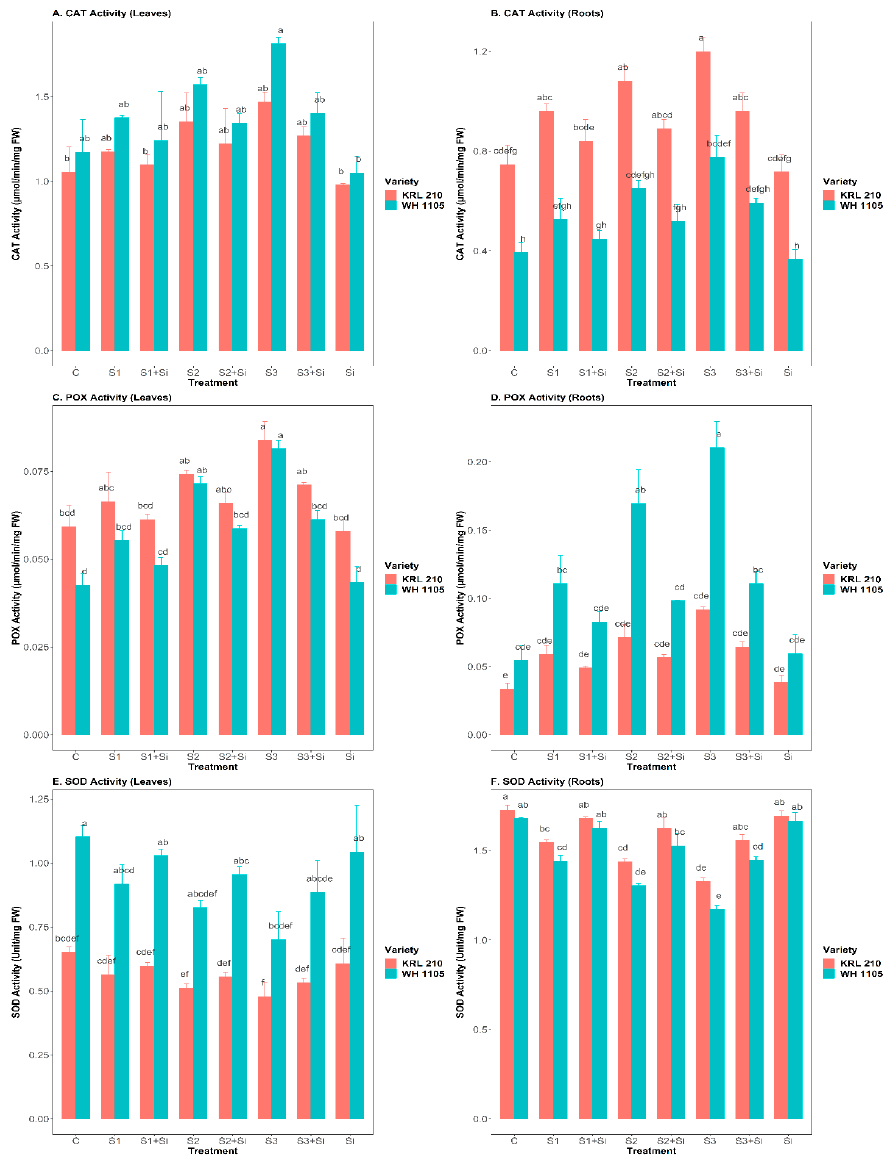
Figure 4. Effect of Si on catalase (CAT) activity of leaves ( A ), CAT activity of root ( B ), peroxidase (POX) activity of leaves ( C ), POX activity of root ( D ), superoxide dismutase (SOD) activity of leaves ( E ), and SOD activity of root ( F ) in salt-stressed wheat plants. Means ± SE; Two-way ANOVA with Tukey’s post hoc test; Each bar having different alphabets was significantly different between treatments ( p < 0.05). C: Control, S1: 40 mM NaCl stress, S2: 80 mM NaCl stress, S3: 120 mM NaCl stress, Si: 2 mM Silicon.